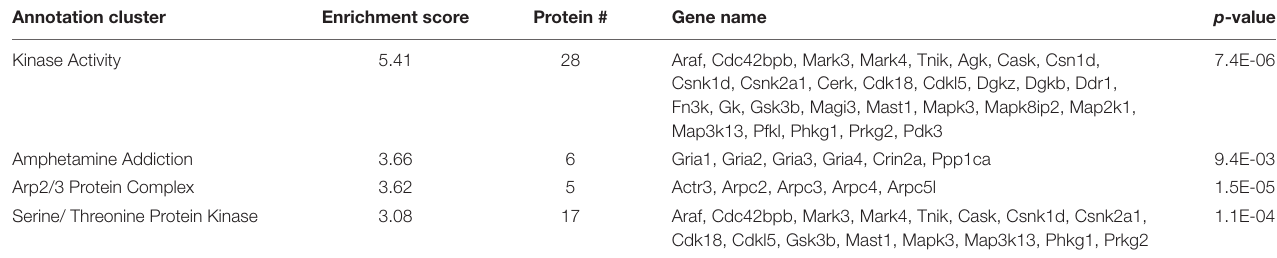
TABLE 2 | DAVID functional analysis of SIPs decreased with SERT Ala56.